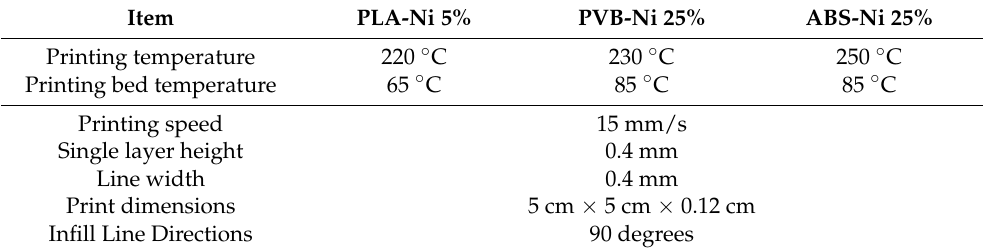
Table 3. FDM printing parameters for the selected feedstock systems.